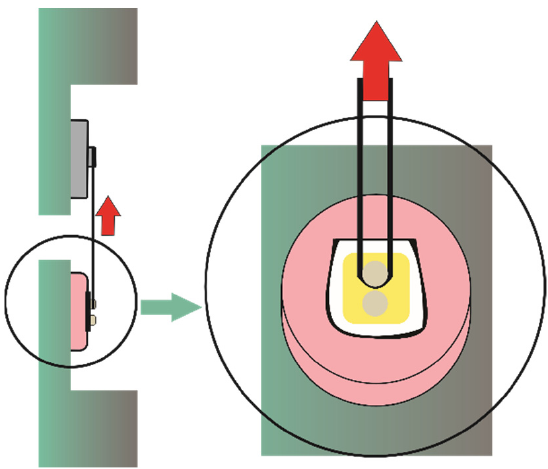
Figure 1. Diagram of the shear bond strength test. Red arrows indicate the direction of the force.